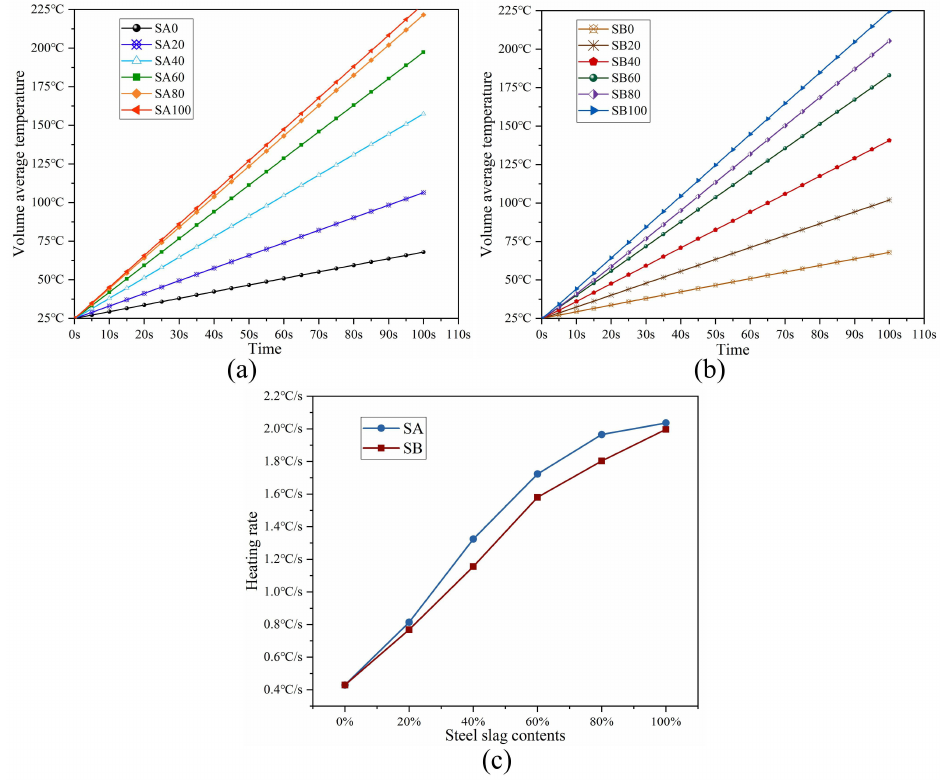
Figure 6. The volume average temperature of SA ( a ) and SB ( b ), with the heating rate ( c